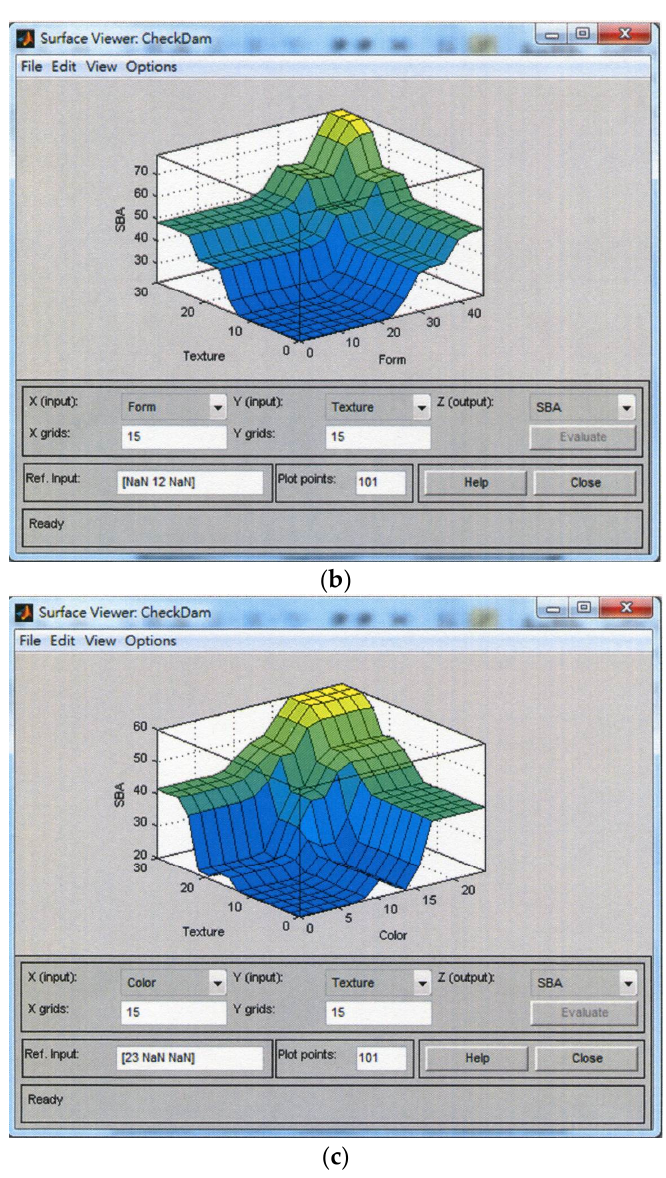
Figure 5. Relationship between texture, color, form and Scenic Beauty Assessment: ( a ) form, color, and Scenic Beauty Assessment; ( b ) form, texture, and Scenic Beauty Assessment; ( c ) color, texture, and Scenic Beauty Assessment.